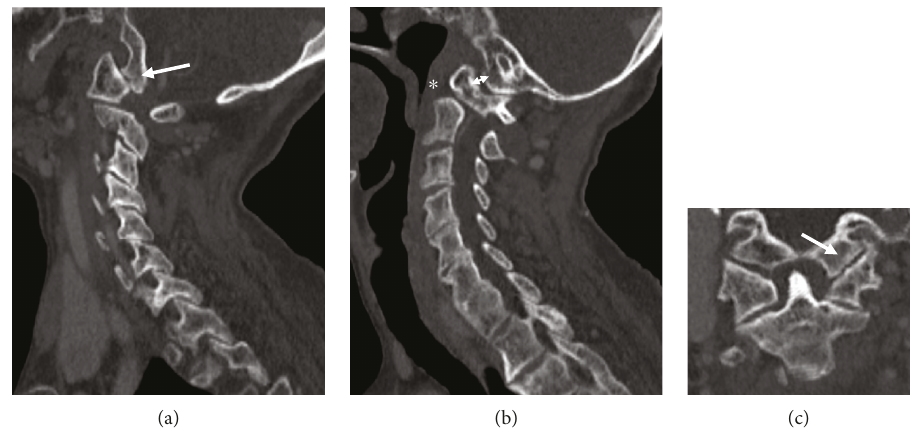
Figure 1: Left parasagittal (a) and coronal (c) CT scan images show a right nondisplaced impaction occipital condyle fracture (arrow), classi fi ed as Anderson and Montesano type I and Tuli type 1. Right parasagittal CT image (b) shows an occipital condyle-C1 interval of